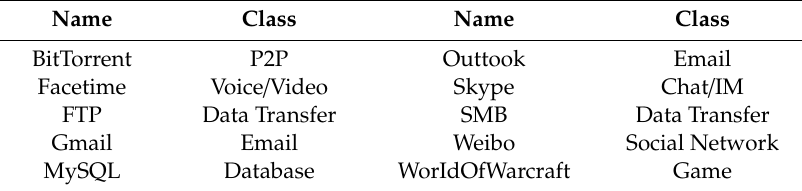
Table 2. USTC-TFC2016 normal tra ffi